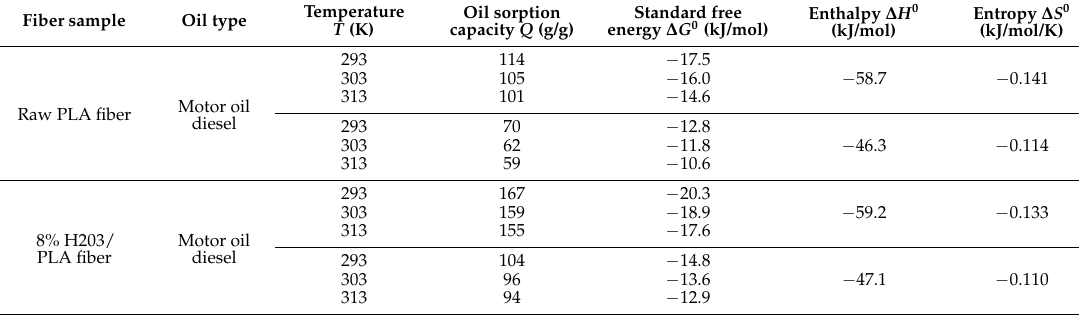
Table 5. Thermodynamic parameters for sorption test of raw PLA fiber and (8% H203)/PLA fiber. Fiber